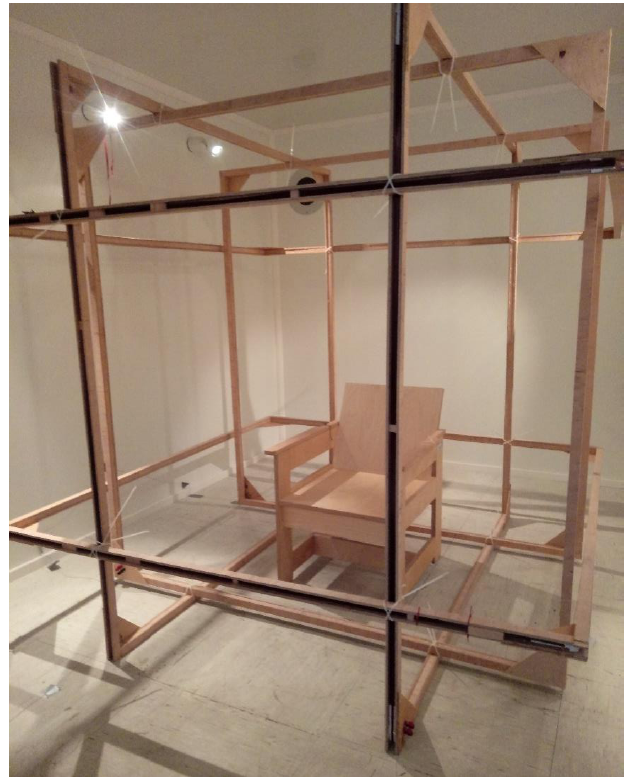
Figure 3. Wooden Helmholtz coils setup installed in a two-layer magnetically shielded room (Vacoshield Advanced, Vacuumschmelze GmbH & Co. KG, Hanau, Germany) at Warsaw University of Technology, Faculty of Mechatronics.